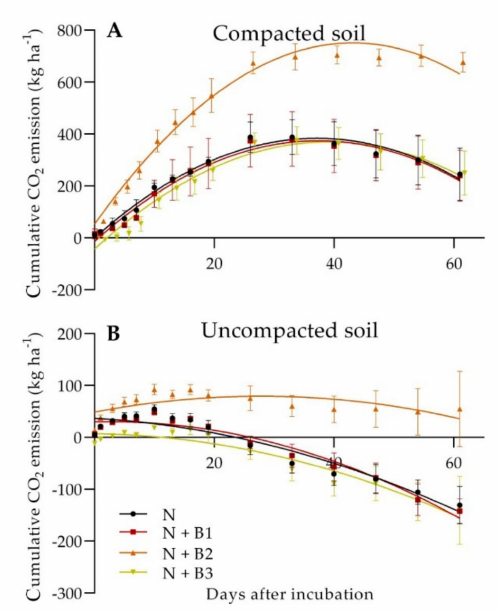
Figure 4. Timeline of cumulative CO 2 emissions from compacted ( A ) and uncompacted ( B )